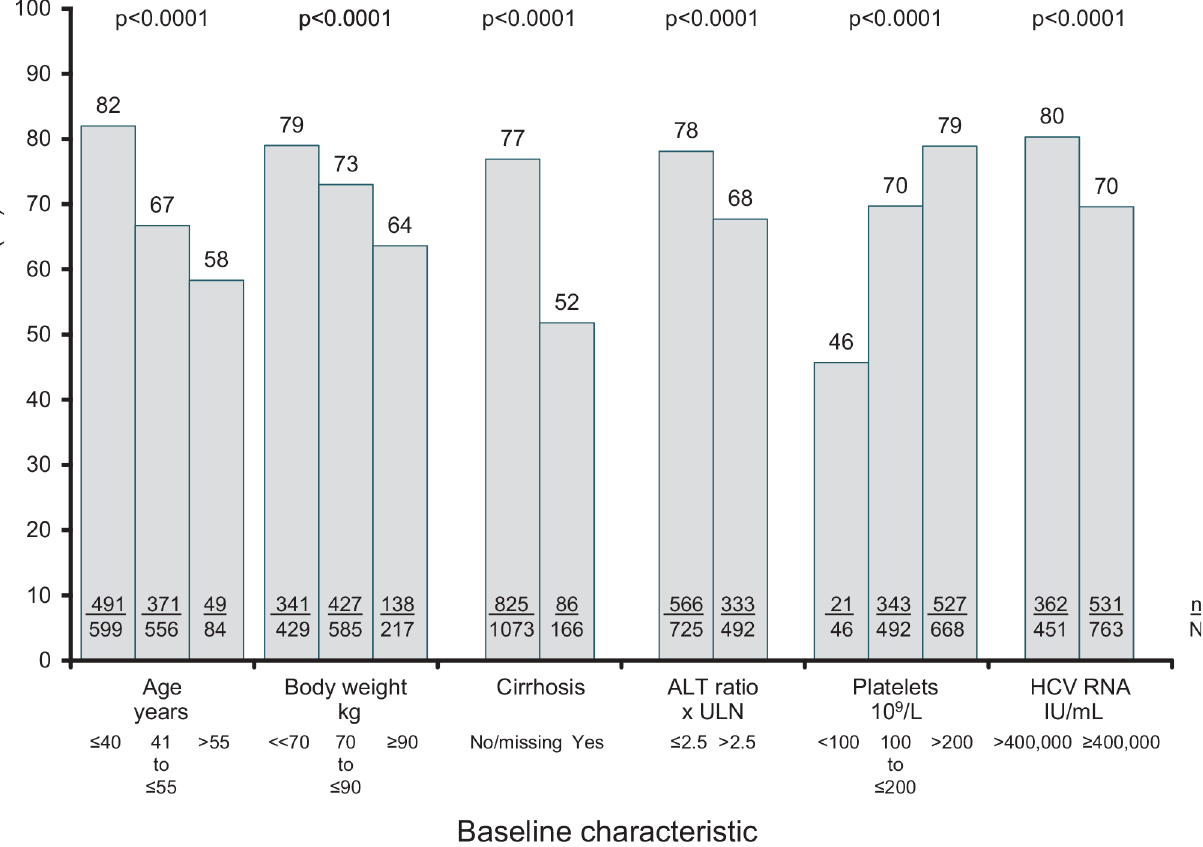
Fig 8. Sustained virologic response by baseline characteristic. ALT = alanine aminotransferase; ALT ratio = ALT divided by ULN for the local laboratory; ULN = upper limit of normal. P-values are based on univariate regression